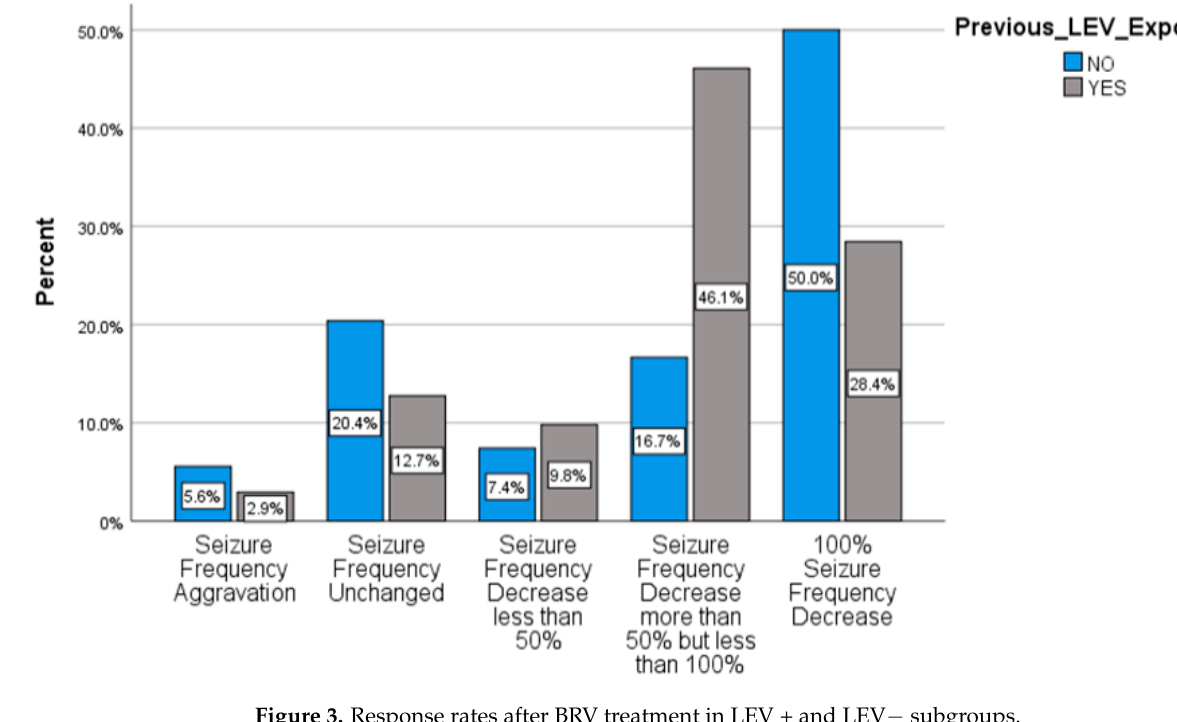
Figure 3. Response rates after BRV treatment in LEV + and LEV −